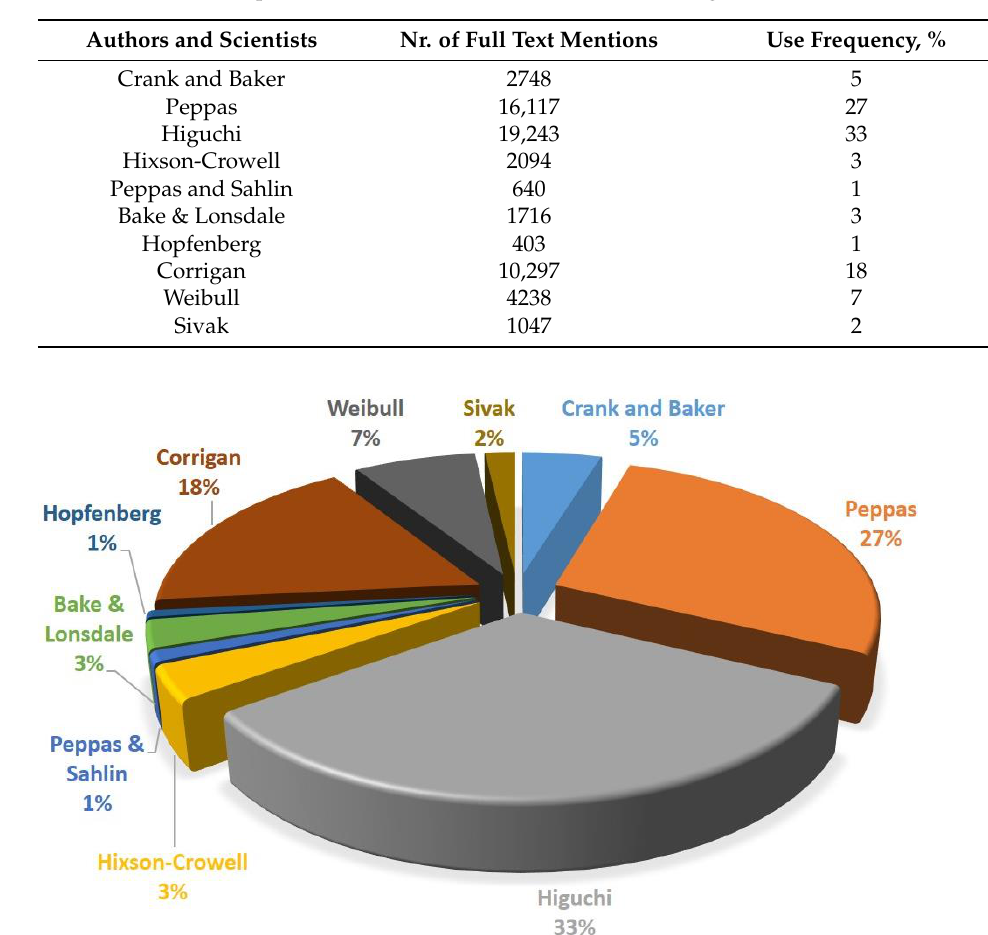
Figure 1. Frequency use distribution of the most famous drug release models.